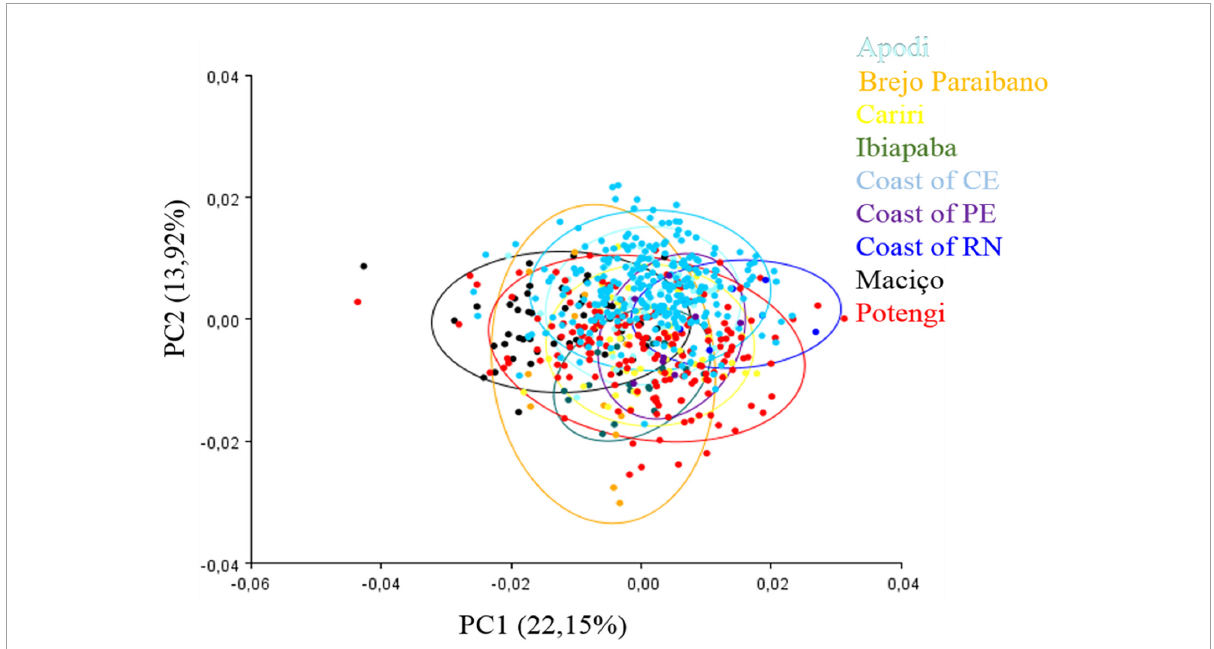
FIGURE3 Principal component analysis of the 13 anatomical landmarks marked at the wing rib junctions of Plebeia flavocincta .